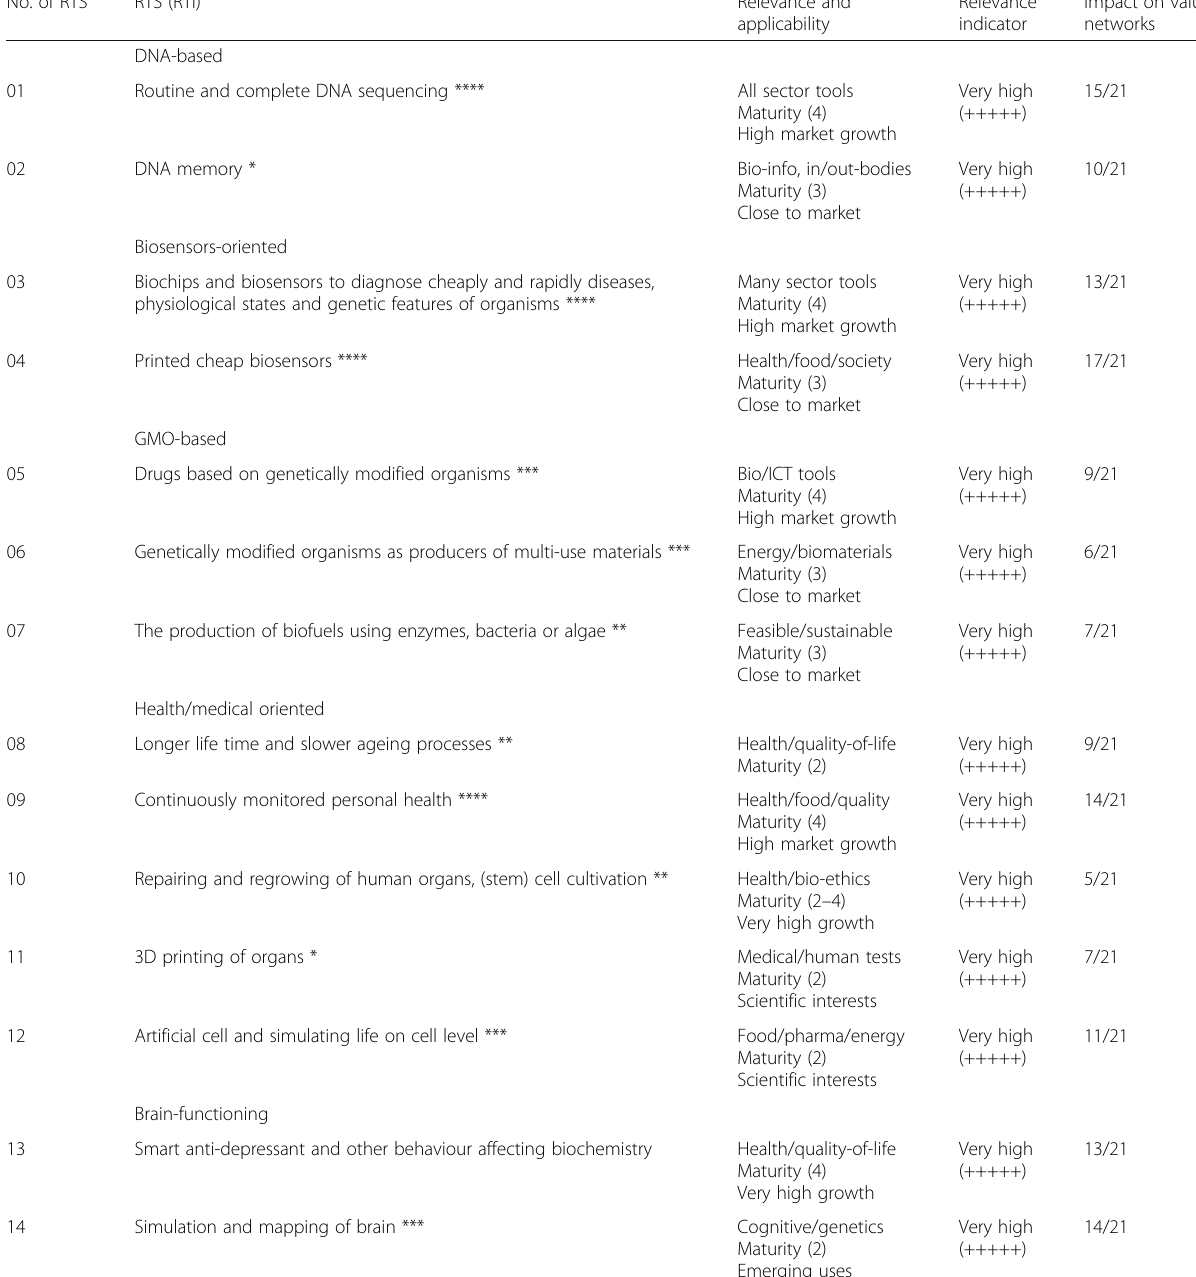
Table 3 Radical technological “ protagonists ” of the bioeconomy emergence [8, 14] No. of